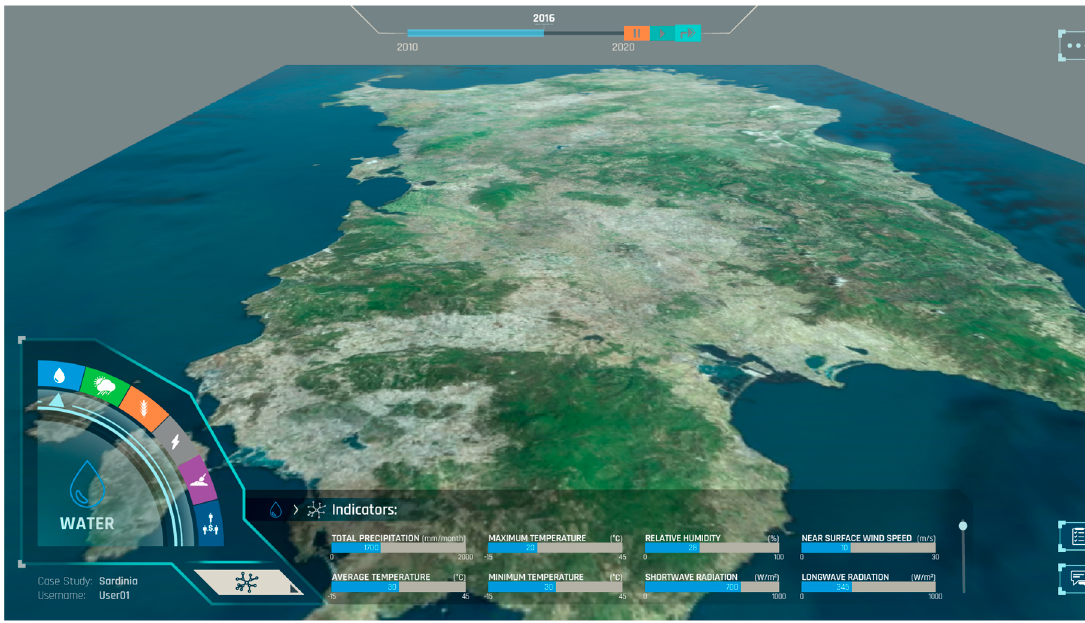
Figure 9. Screenshot from the developed prototype serious game front-end for the Sardinia fast-track case study.